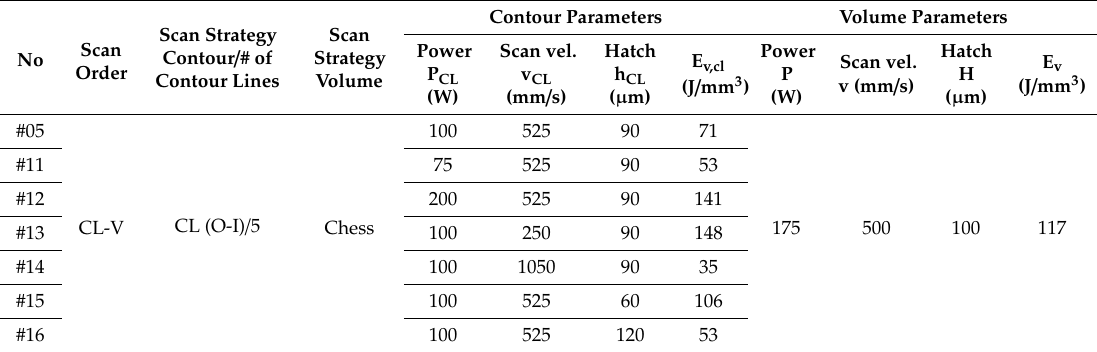
Table 4. Varying the main laser parameters, E V = variable.